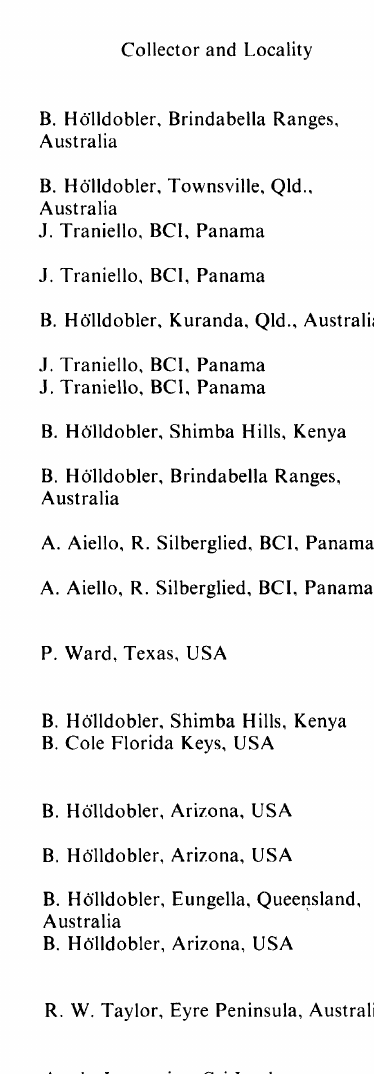
Sub fam il.l’ species MYRMECIINAE M’rmecia